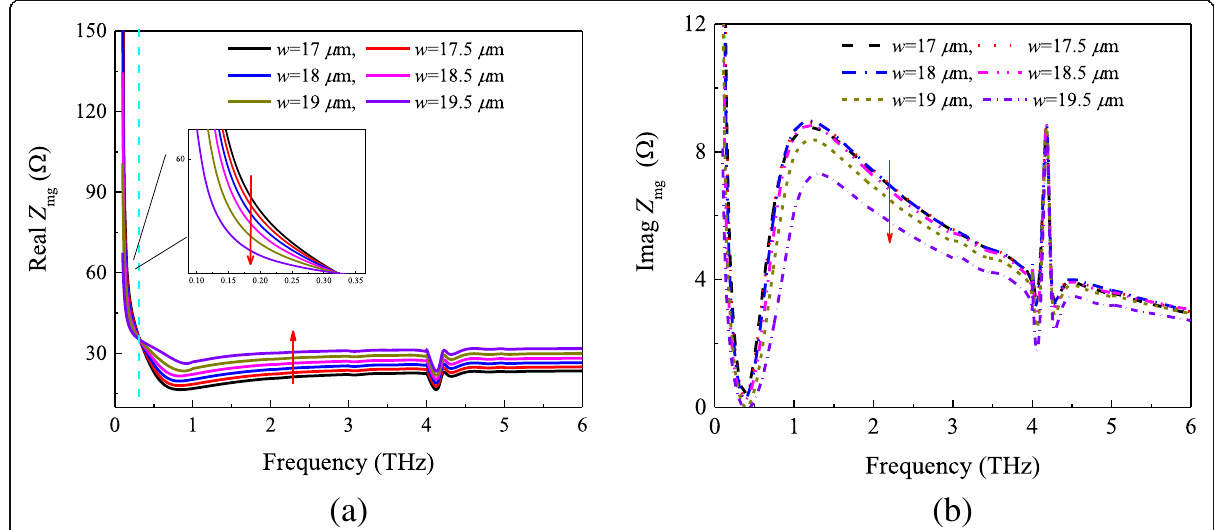
Fig. 7 Metasurface-graphene film impedance Z mg retrieved from S -parameters with the chemical potential μ c = 0.4 ev. a Real and b imaginary parts